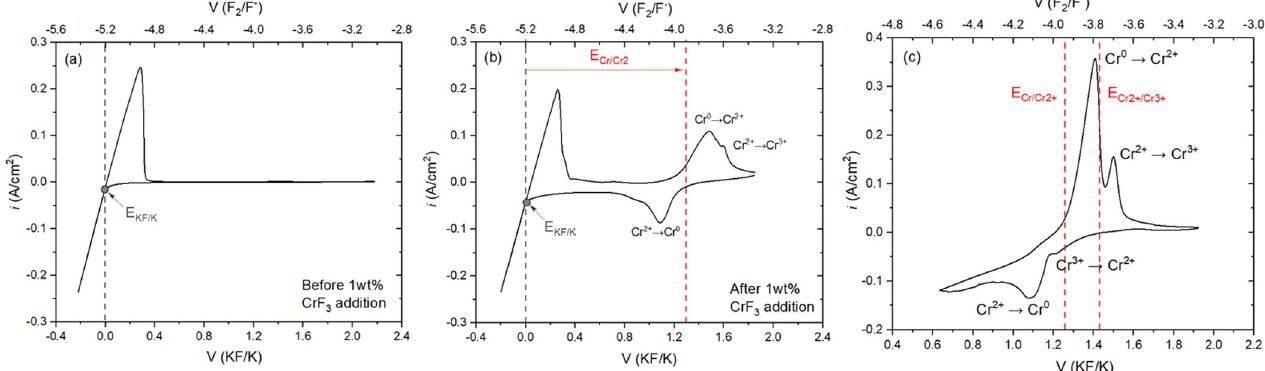
Fig. 1 Cyclic voltammogram of Pt wire in a FLiNaK salt at 600°C. ( a ) shows the cyclic voltammogram before and after the addition of ( b ) 1.0 wt% and ( c ) 0.42 wt% of CrF 3 at 600 °C. a , b indicate the equilibrium potential of KF reduction (E KF/K ). The red dotted lines in ( b ) and ( c ) show the approximate experimentally determined equilibrium redox potential of Cr/Cr 2 + redox couples (E Cr/Cr2 +